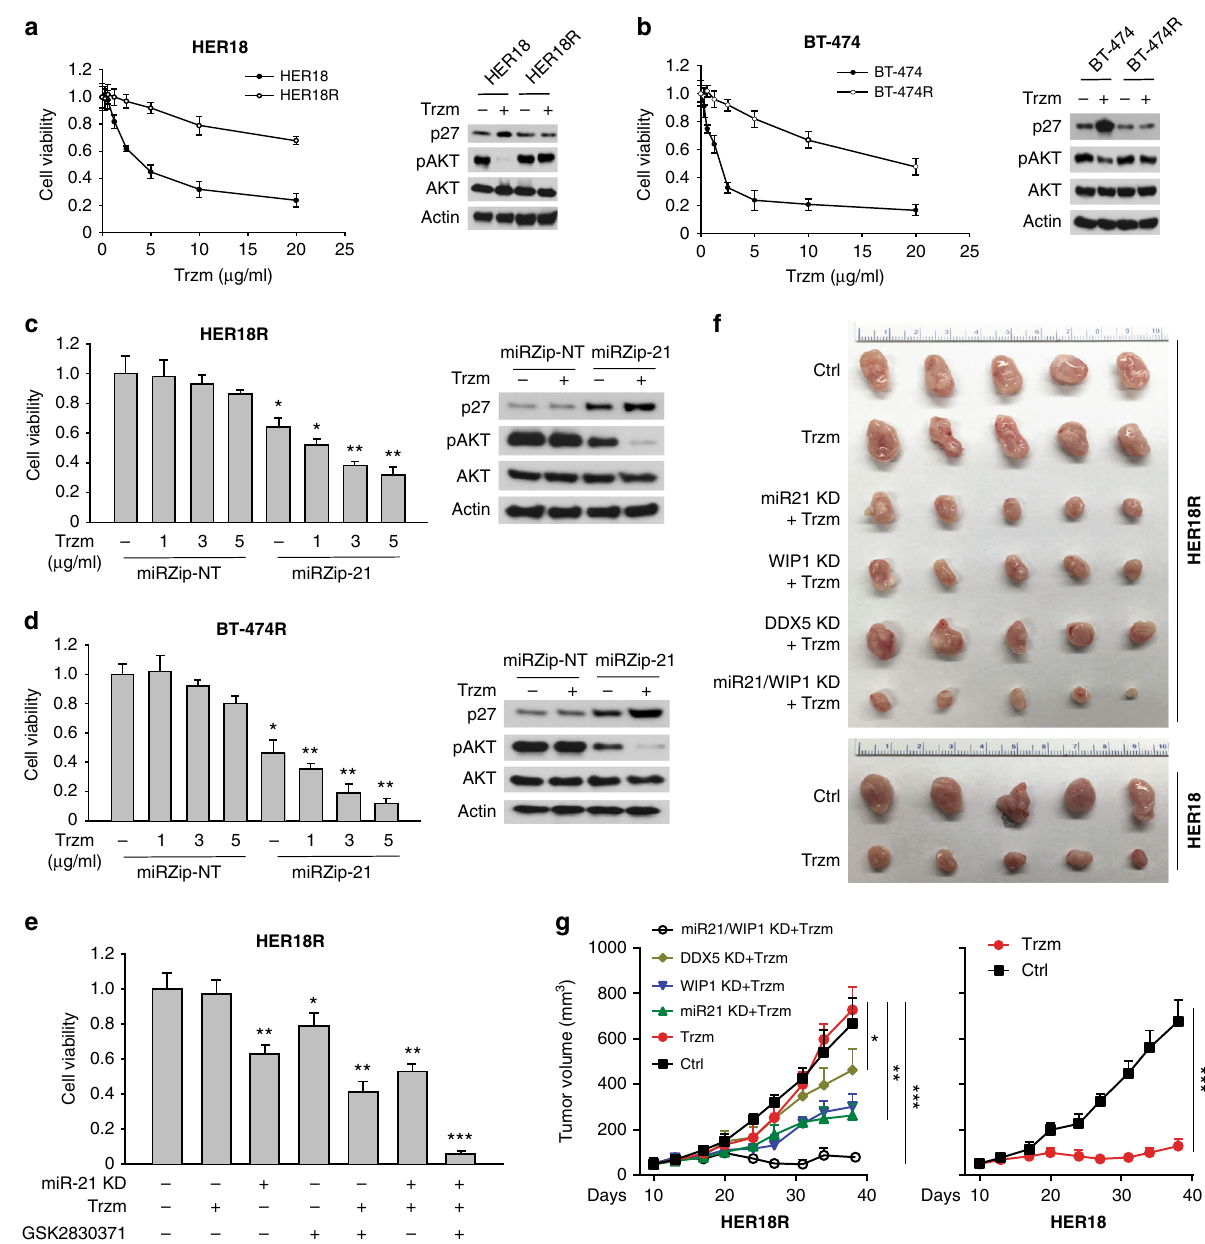
Fig. 6 Inhibition of miR-21 and WIP1 sensitizes HER2 + breast cancer cells to the treatment of trastuzumab. a , b Parental or trastuzumab-resistant HER2 + breast cancer cells (HER18 or BT-474) were incubated with trastuzumab at the indicated concentrations for 72 h. The cell viability was then measured and these results are presented as % vehicle ± SD. The cell lysates were subjected to western blot analyses with the indicated antibodies (right panels). c , d HER18R ( c ) or BT-474R ( d ) cells with or without Dox-induced miR-21 knockdown were incubated with indicated concentrations of GSK2830371 for 72 h. The cell viability was then measured and these results are presented as % vehicle ± SD. The cell lysates were subjected to western blot analyses with the indicated antibodies (right panels). e HER18R cells with or without Dox-induced miR-21 knockdown were incubated with GSK2830371 (0.2 µ M) and/or trastuzumab (1 µ g ml − 1 ) for 72 h. The cell viability was then measured and these results are presented as % vehicle ± SD. f , g Gross tumor images ( f ) and tumor growth curves ( g ) of xenograft tumors derived from orthotopically implanted parental or trastuzumab-resistant HER18 cells expressing Dox-inducible WIP1 or DDX5 shRNA or anti-miR21 oligonucleotides with trastuzumab treatment (5 mg kg − 1 , twice per week). * p